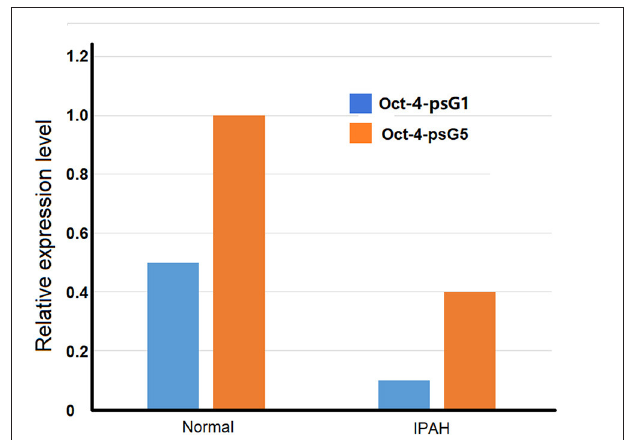
FIGURE 2 | Comparison of expression of Oct-4 pseudogenes PSG1 and PSG5 in pulmonary arterial smooth muscle cells (PASMC) from idiopathic pulmonary arterial hypertension (IPAH) patients and normal